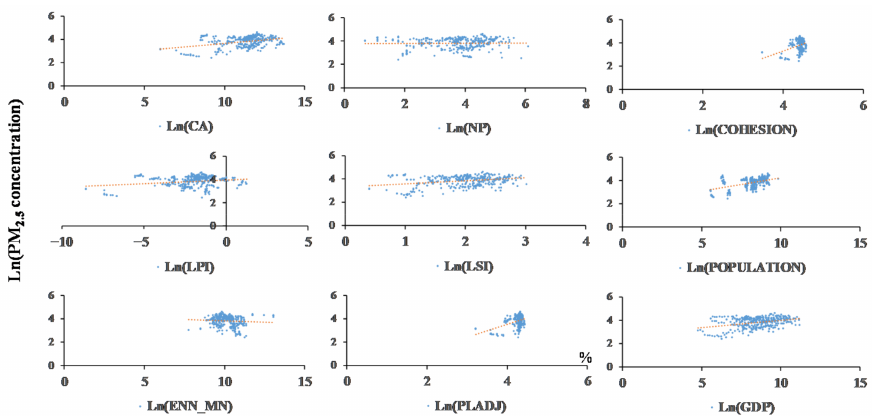
Figure 6. Scatterplots of urban forms (UF) metrics vs. PM 2.5 concentration at the provincial scale.